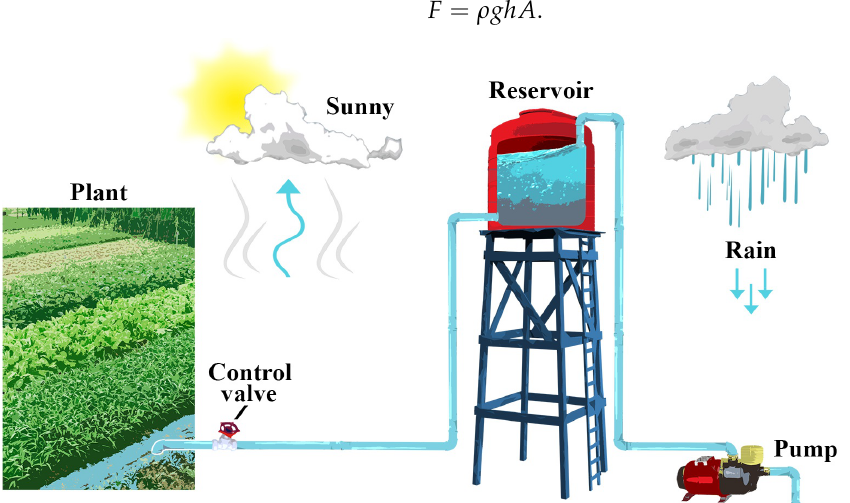
Figure 2. Uncertainty analysis of valve control for precision irrigation in the